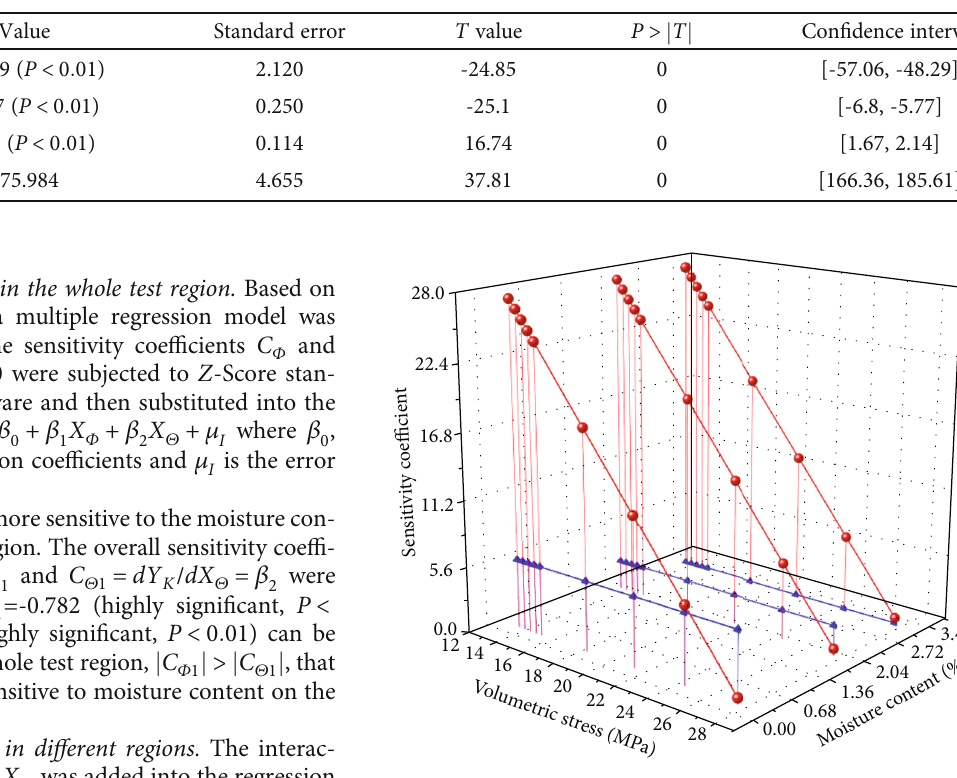
Table 4: Calculation results of regression coe ffi cients.